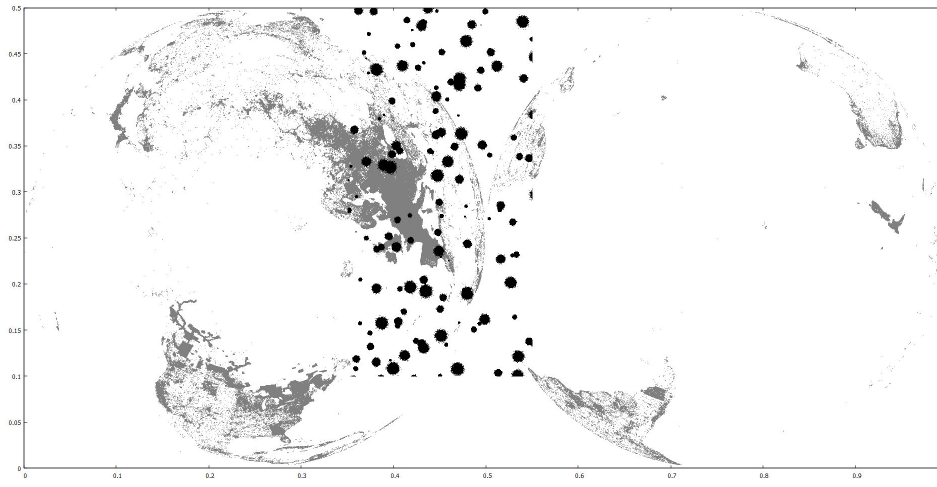
Figure 19. Parks (gray) and synthetic 3.9M (black)